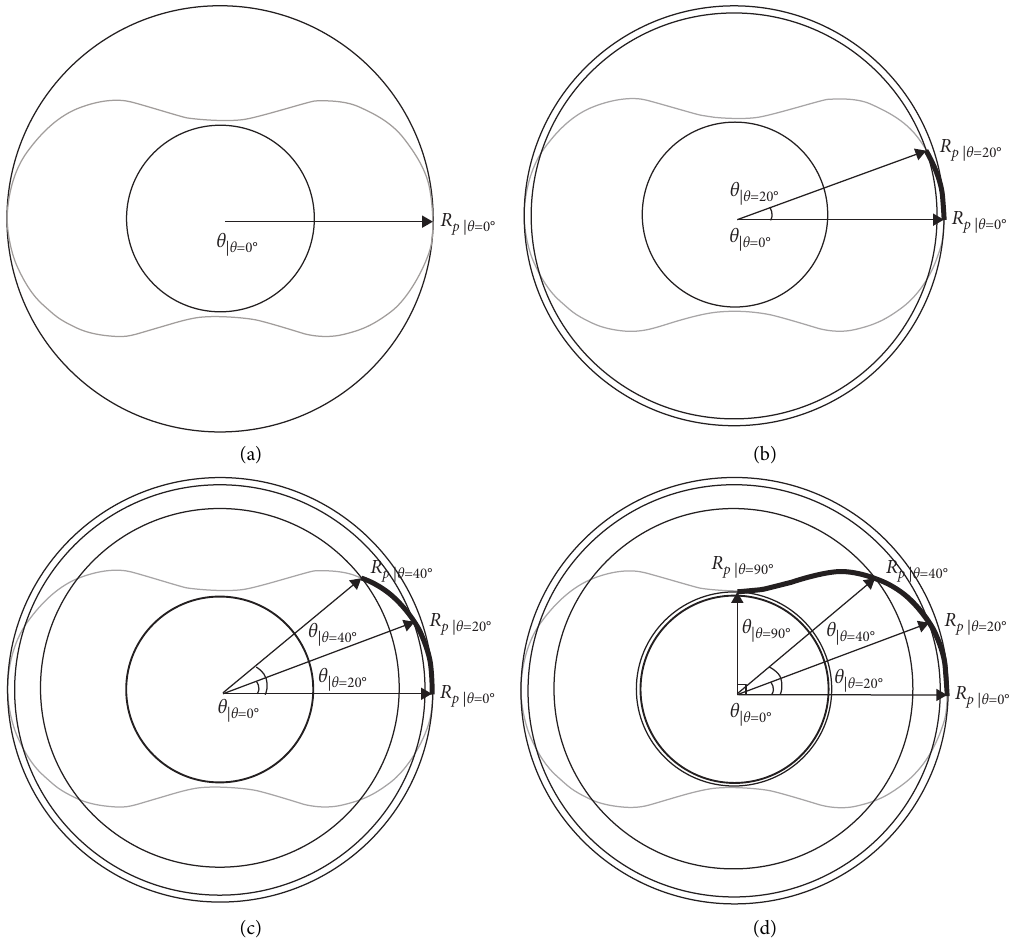
Figure 3: R � 0 ° ,(b) θ � 20 ° , (c) θ � 40 ° , and (d) θ � 90 ° p with different θ : (a) θ